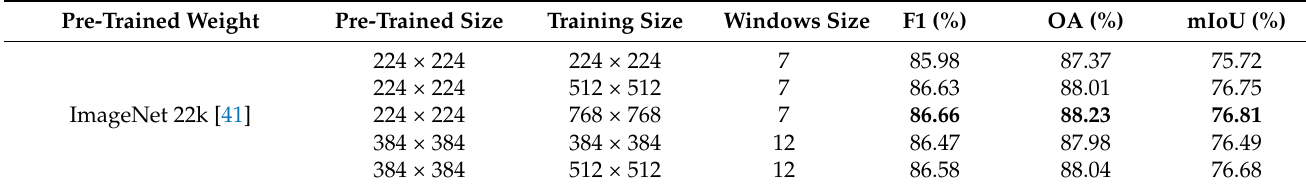
Table 3. Study for the training size on Vaihingen